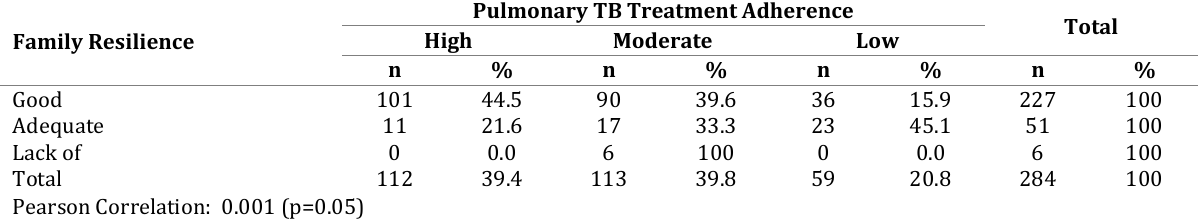
Table 3. Effects of Family Resilience on Adherence with Pulmonary TB Treatment Family